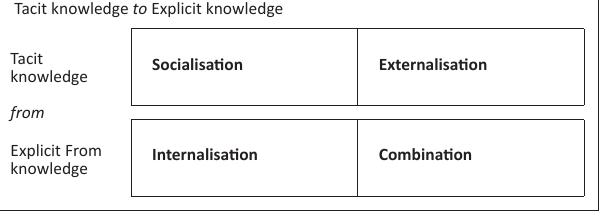
FIGURE 1: Four modes of knowledge conversion.